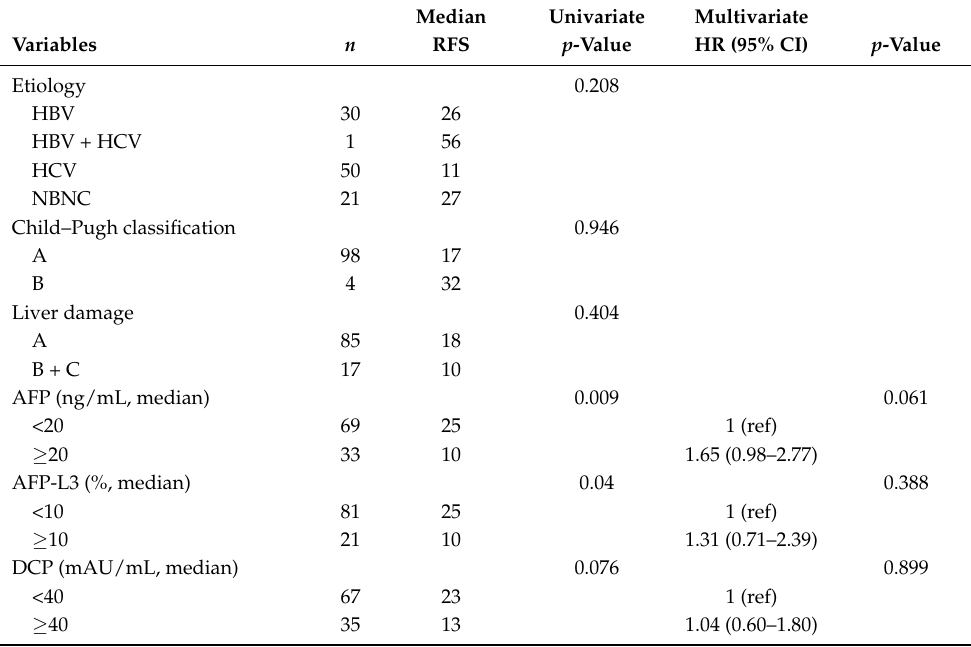
The univariate and multivariate analyses of RFS for recurrent HCC are shown in Table 4. The optimal cut-off values of tumor markers to assign the patients into the two groups based on the greatest difference in the RFS were 20 ng/mL for AFP ( p = 0.009), 10% for AFP-L3 ( p = 0.04), and 40 mAU/mL for DCP ( p = 0.076) when the minimum p -value approach was used (Supplementary Figure S1A–C). Multivariate analysis revealed that locoregional therapy as the previous treatment, multiple tumors, and portal venous invasion were the prognostic factors of RFS in recurrent HCC. Table 4. Univariate and multivariate analyses of recurrence-free survival.